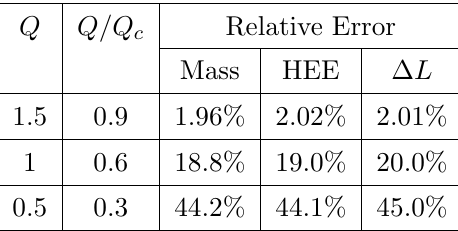
Table 4 . Comparing the Relative Errors. We have computed the relative error between Areas I and II on the Temperature/Mass plane and we have compared this with those on the T /(cid:1) S and T /(cid:1) L planes. The numerical errors in both cases are very close to that in the T / M